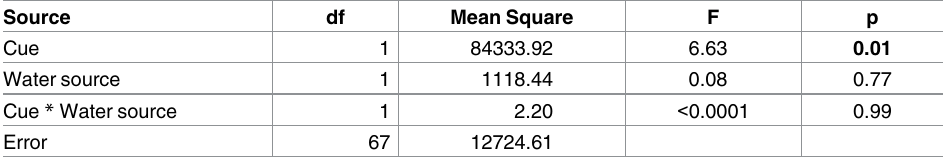
Table 2. Comparison of the time differences spent by Pseudochromis fuscus to cue injected (prey damage-releasedodour or control seawatercue) versus seawaterinjected chamberswithin y-mazes with either healthy or dead-degraded coral treated background water. n (healthy water source, damage- released odour) = 19, n (healthywater source, control seawater cue) = 16, n (degradedwater source, dam-